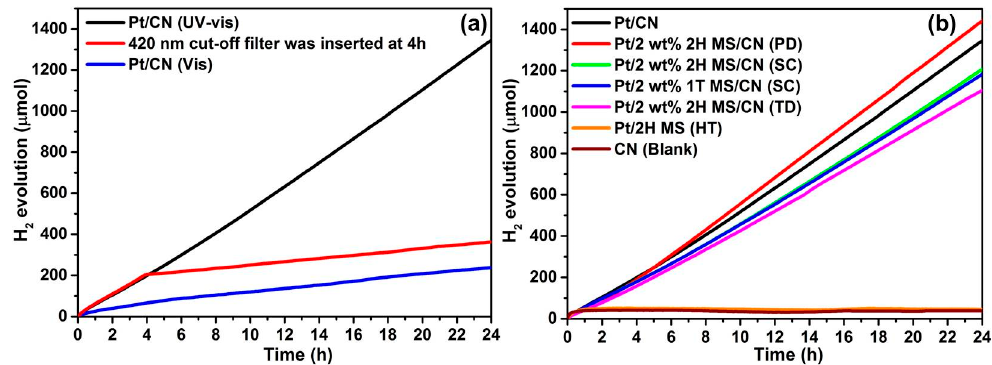
Figure 1. Photocatalytic H 2 production of MoS 2 -free Pt / CN as a function of time in the presence of lactic acid: ( a ) under UV-vis light (black), under visible light ( λ > 420 nm, blue) and with a 420 nm cut-o ff filter inserted after 4 h irradiation under UV-vis light (red); ( b ) for di ff erently prepared MS-CN composites under UV-vis light irradiation. Reaction conditions: 24.5 mg CN or MS-CN, 0.2 mL of a H 2 PtCl 6 stock solution equal to 0.5 mg Pt, 24.8 mL H 2 O / lactic acid (final ratio 9 / 1 ( v / v )), 25 ◦ C, 1.5 W light power (Xe lamp) without (UV-vis) or with (vis) a 420 nm cut-o ff